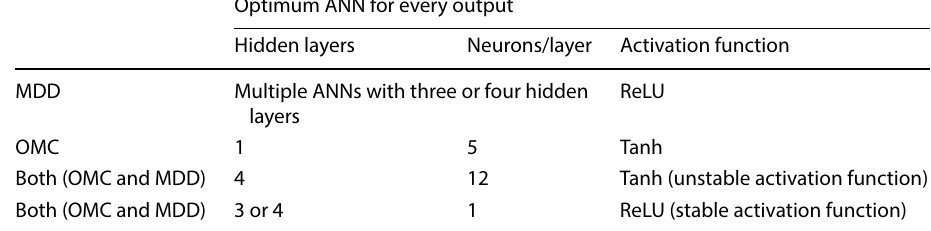
Optimum ANN for every